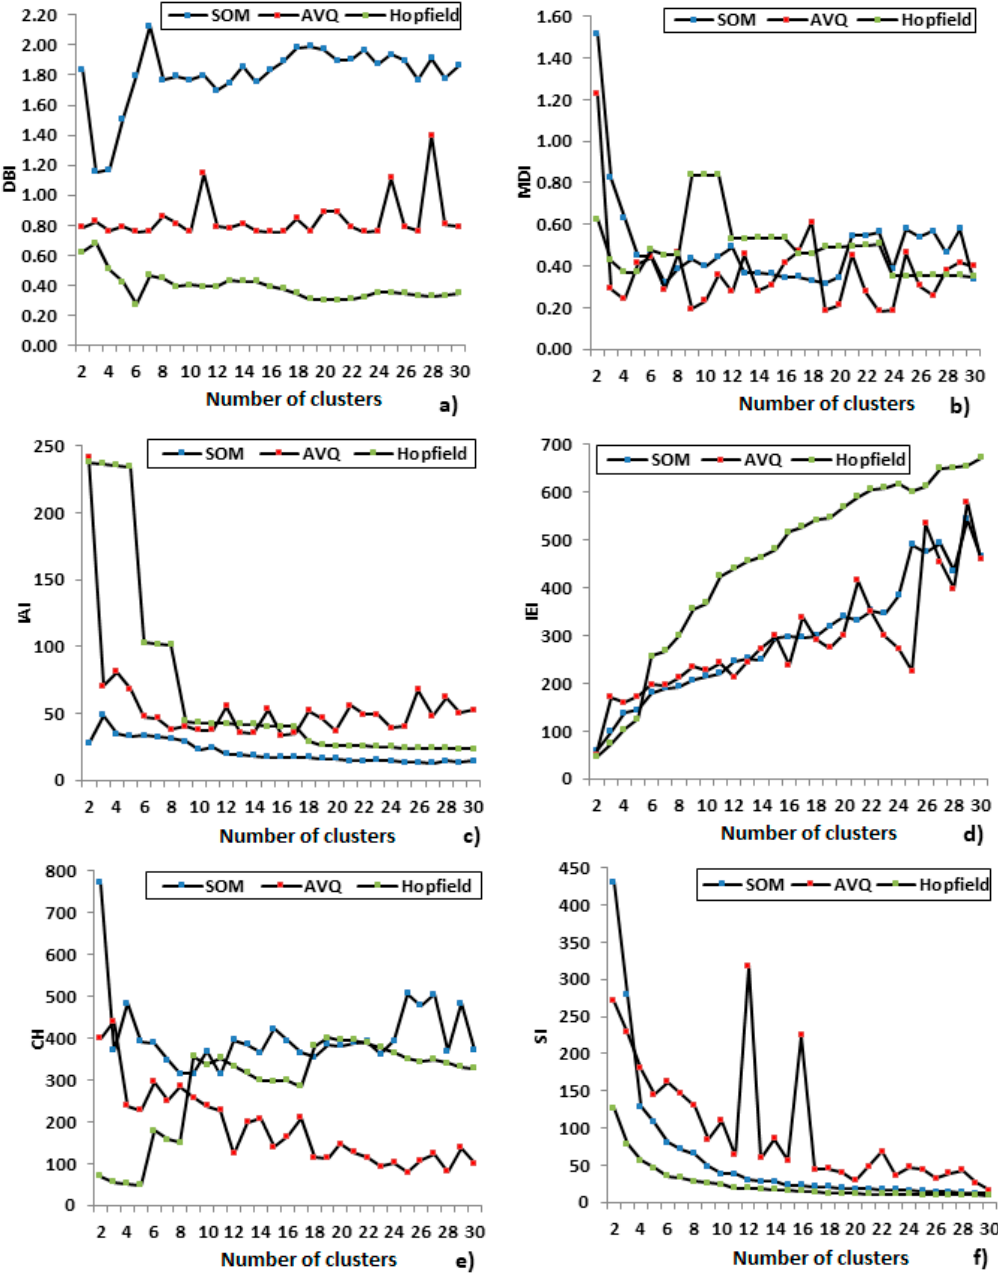
Figure 8. Comparison of the neural network-based algorithms using: ( a ) DBI, ( b ) MDI, ( c ) IAI, ( d ) IEI, ( e ) CH, ( f ) SI.